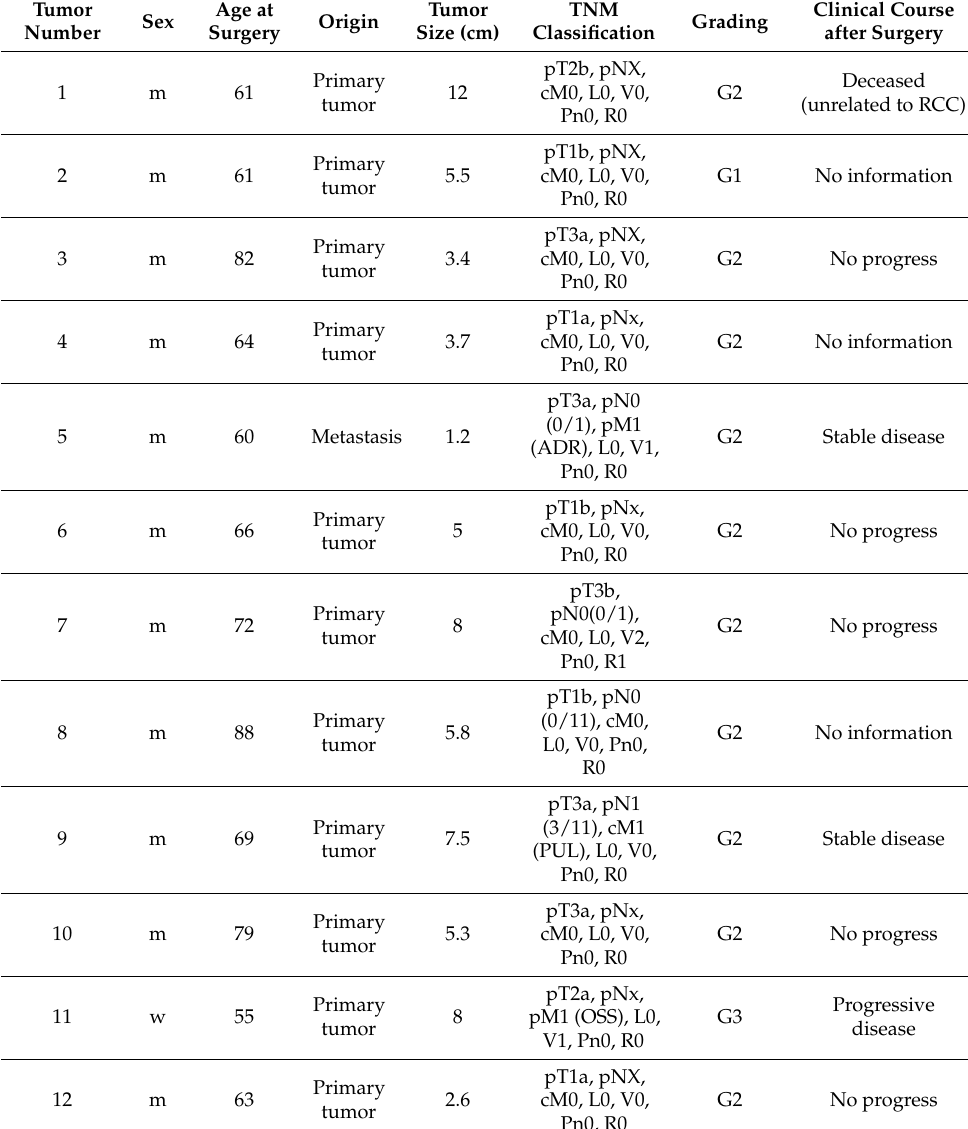
Table 1. Clinicopathological information of the patient